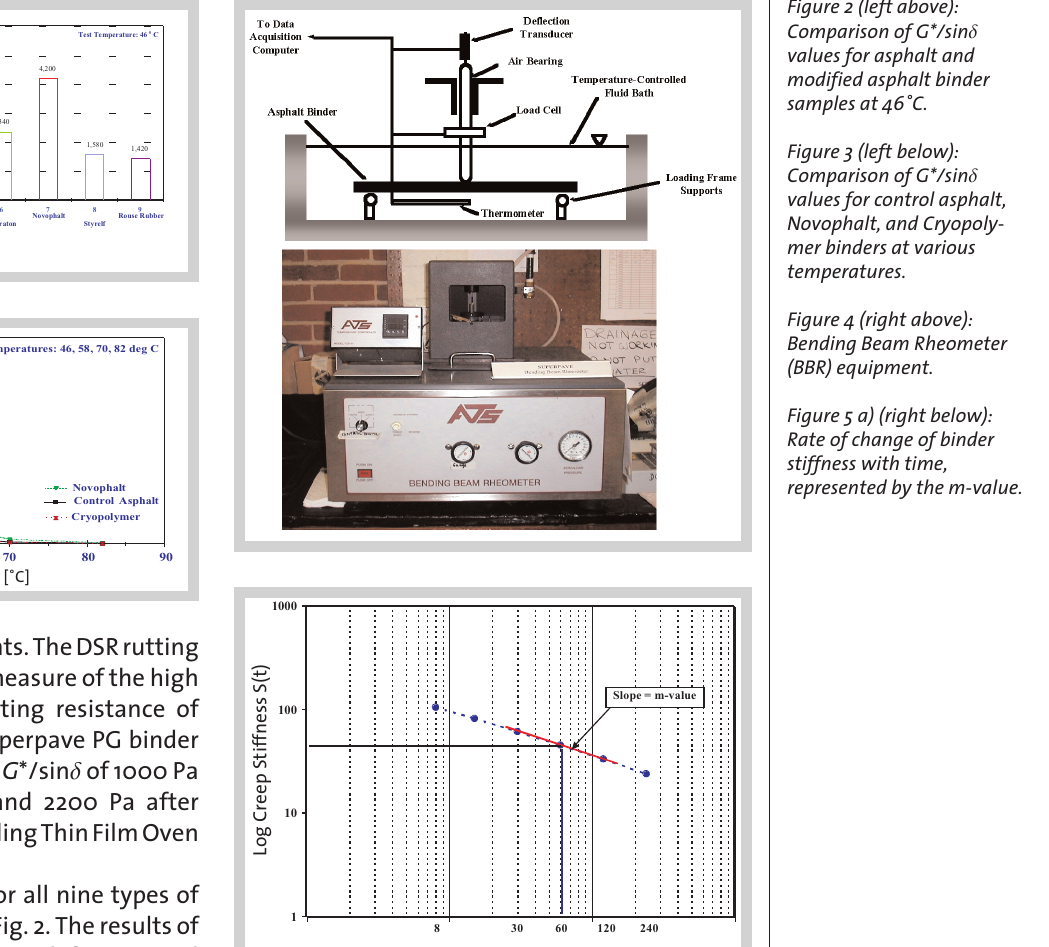
Figure 2 (left above): Comparison of G*/sin d values for asphalt and modified asphalt binder samples at 46˚C. Figure 3 (left below): Comparison of G*/sin d values for control asphalt, Novophalt, and Cryopoly- mer binders at various temperatures. Figure 4 (right above): Bending Beam Rheometer (BBR) equipment. Figure 5 a) (right below): Rate of change of binder stiffness with time, represented by the